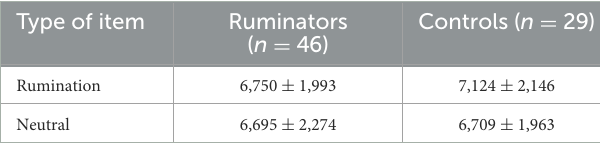
TABLE 8 Average EEG length (time points) of the two types of items in different groups ( ¯ x ±